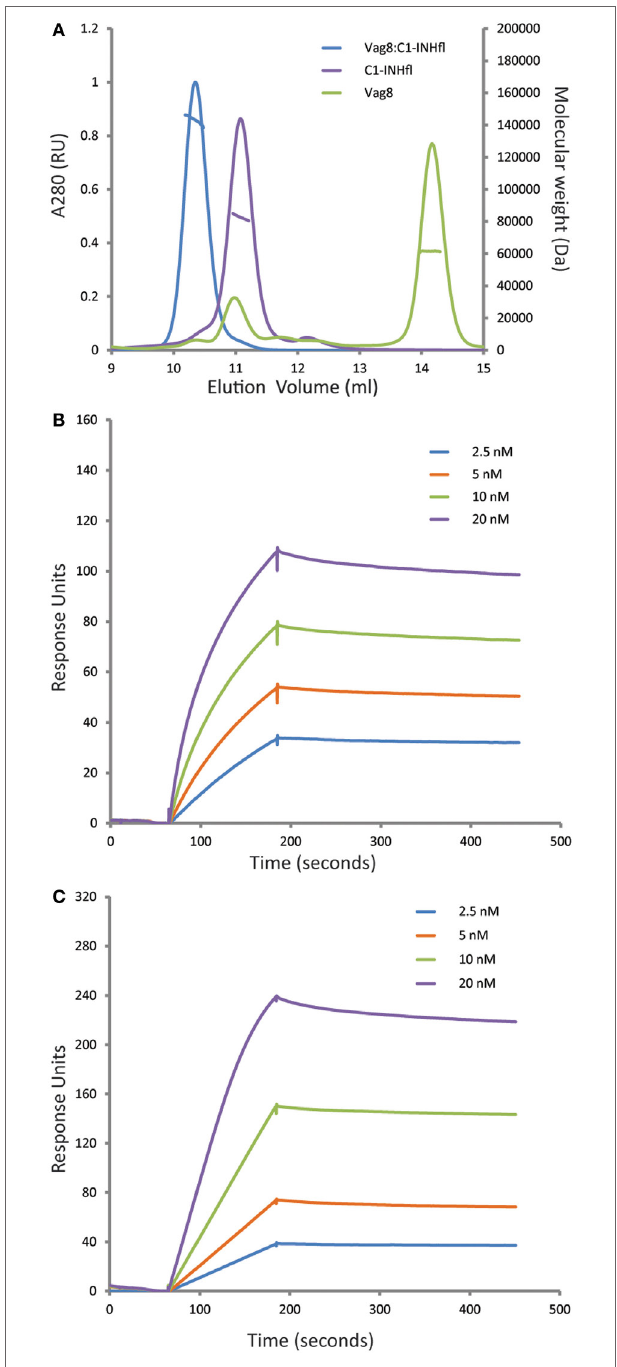
FigUre 1 | Virulence associated gene 8 (Vag8) and complement regulator C1 inhibitor (C1-INH) interact to form a tight 1:1 complex. (a) Size exclusion chromatography with multi-angle light scattering analysis (SEC-MALS) of Vag8 (green), C1-INH (purple), and Vag8_C1-INH complex (blue). The masses calculated from the scattering are shown as lines across the peaks. Protein conjugate analysis demonstrates that the mass of complex (146 kDa) corresponds to 118 kDa of protein and 28 kDa of sugar. This is consistent with a 1:1 complex of Vag8 (60 kDa) and glycosylated C1-INH (58 kDa protein/28 kDa sugar). (B,c) SPR analyses of the binding between Vag8 on the chip surface and increasing concentrations of C1-INH FL (B) and C1-INH NT98 (c) in